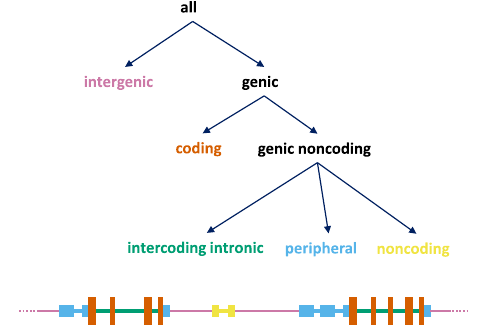
Fig. 2 Event types. We assign a label ‘ intergenic ’ (purple) to any event that falls between transcripts; a label ‘ coding ’ (brown) is assigned to events that affect coding exons; a label ‘ intercoding intronic ’ (green) is assigned to events that affect an intron splitting two coding exons; a label ‘ peripheral ’ (blue) is assigned to events that affect coding transcripts but are neither coding nor ‘ intercoding intronic ’ ; a label ‘ noncoding ’ (yellow) is assigned to events that affect noncoding transcripts. The peripheral events affect the untranslated regions of the coding transcripts (UTRs) or the introns that split UTRs. We use RefSeq transcript models downloaded from the UCSC genome browser to fi nd the genomic coordinates the exons 38 . Table 3 Combined de novo LGDs and coding CNVs in simplex and multiplex autism.